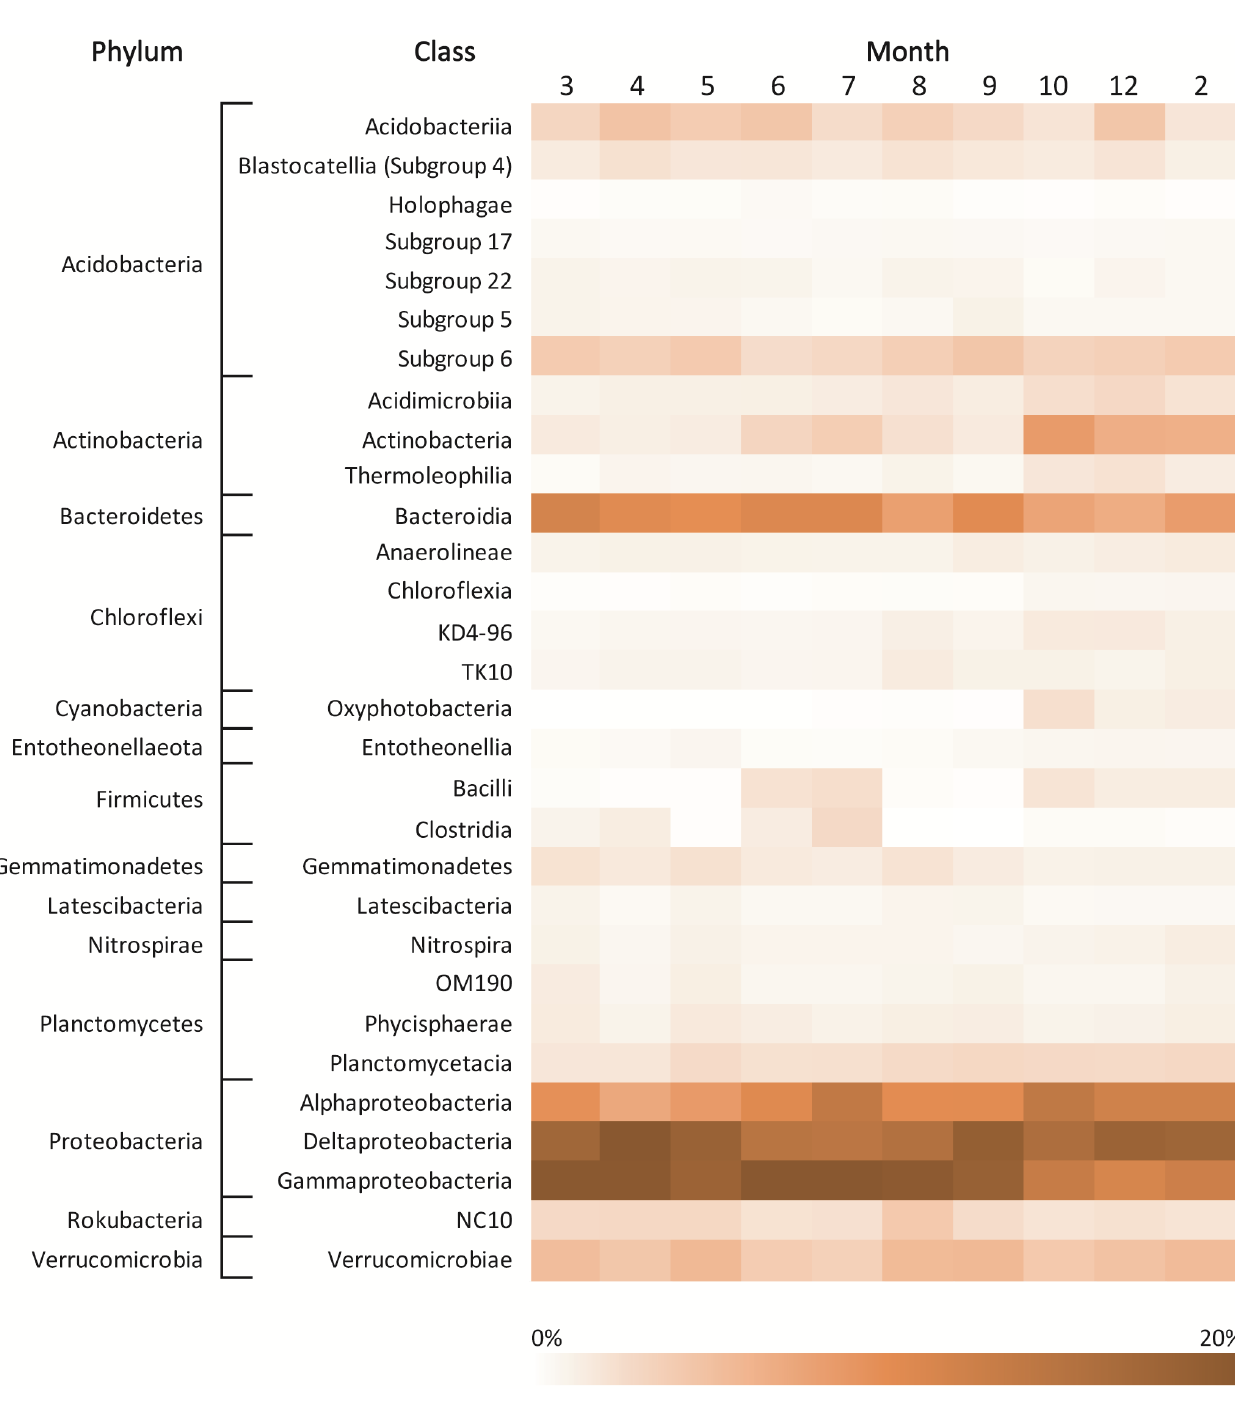
Figure 5. Relative abundances of different classes in active bacterial communities of the upper or- ganic soil horizon throughout the